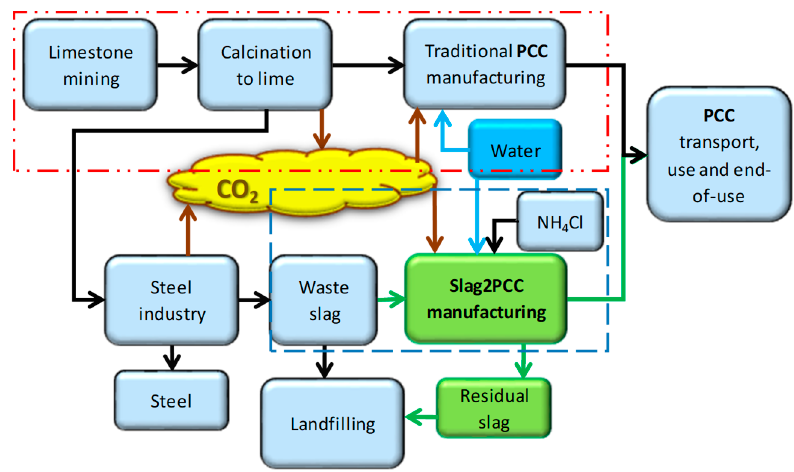
Figure 11. System boundaries for PCC production using traditional processing (red striped line box) and the use of the slag2PCC concept (blue striped line box).